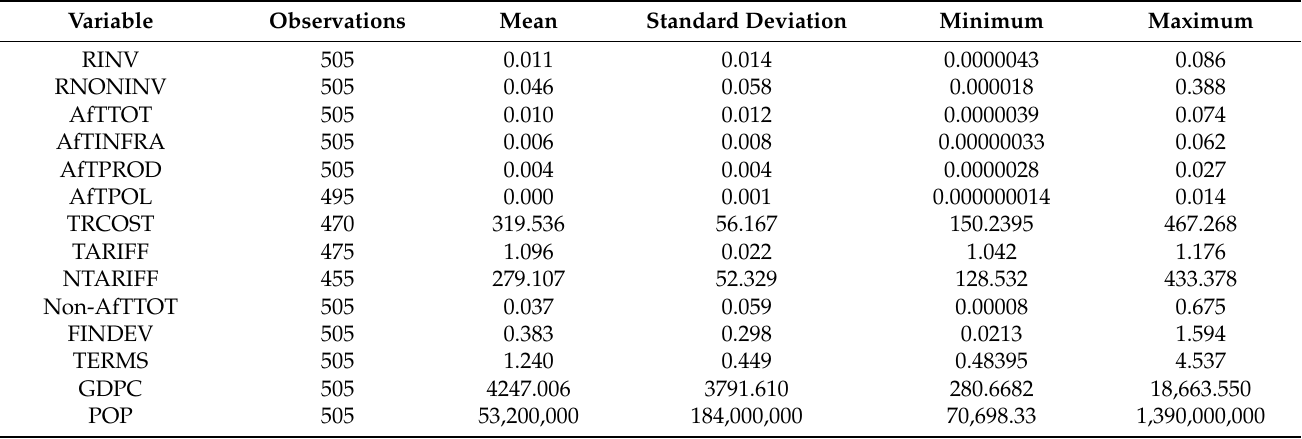
Table A2. Descriptive statistics on variables used in the analysis of the effect of AfT flows on investment-remittance flows.